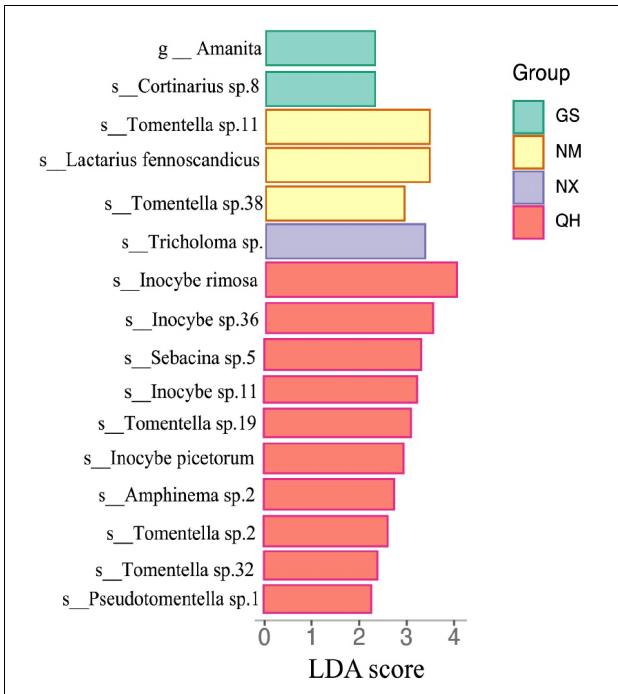
FIGURE 5 | Histogram of LAD scores (LDA score > 2.0 and P < 0.05) for differentially abundant OTU among the four sites.